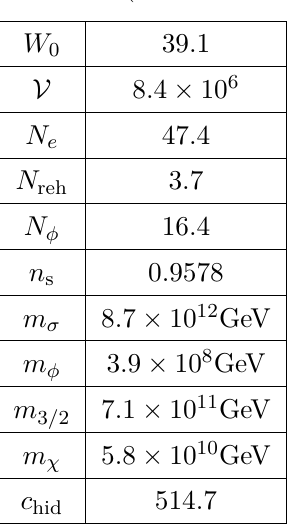
Figure 4 . Scalar spectral index coloring of the entire data set. Black dots correspond to n s within the 2 σ range, while red dots have n within 3 σ (but outside 2 σ ). s